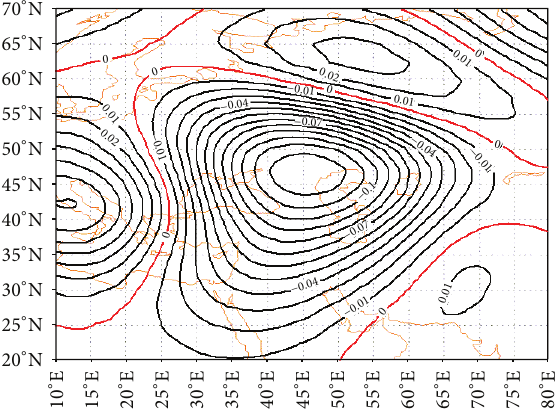
Figure 24: The seventh component of 500 HPa geopotential height level data.